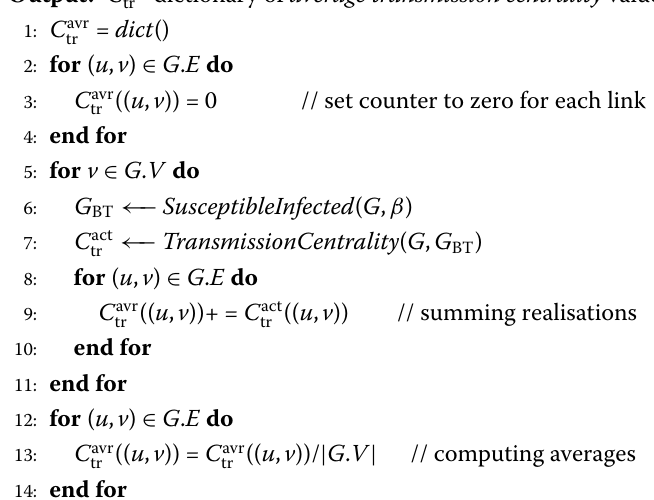
Algorithm 3: Average transmission